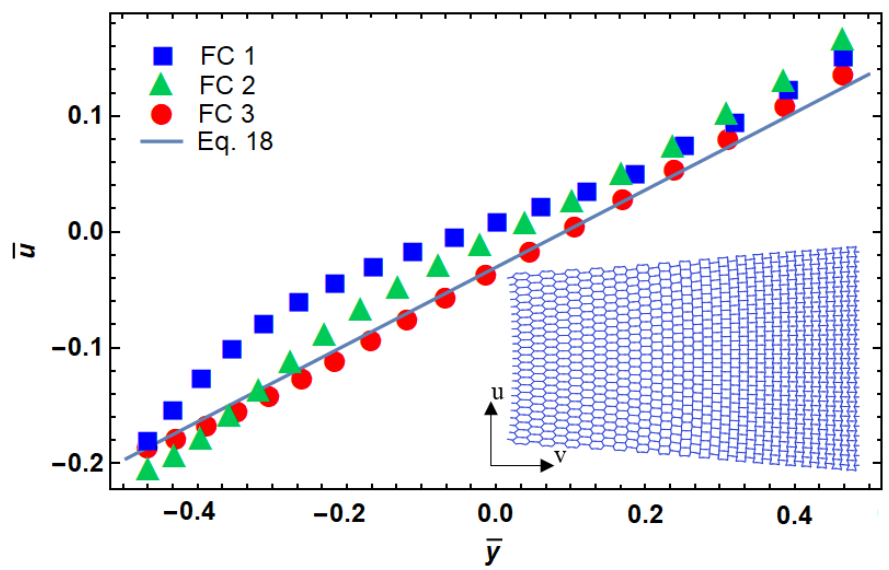
Figure 7. Functionally graded design of a re-entrant cellular plate with non-dimensional lateral and longitudinal deformation.